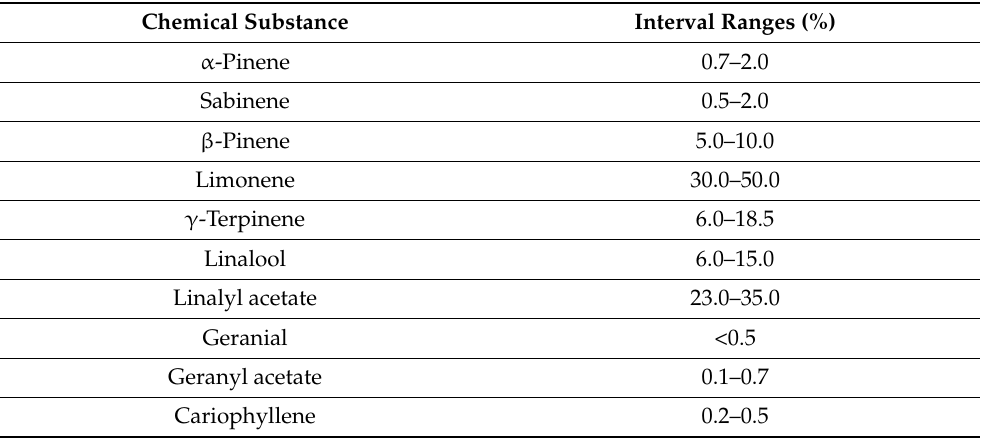
Table 1. Composition of bergamot essential oil (BEO) according to the certificate of analysis. Chemical